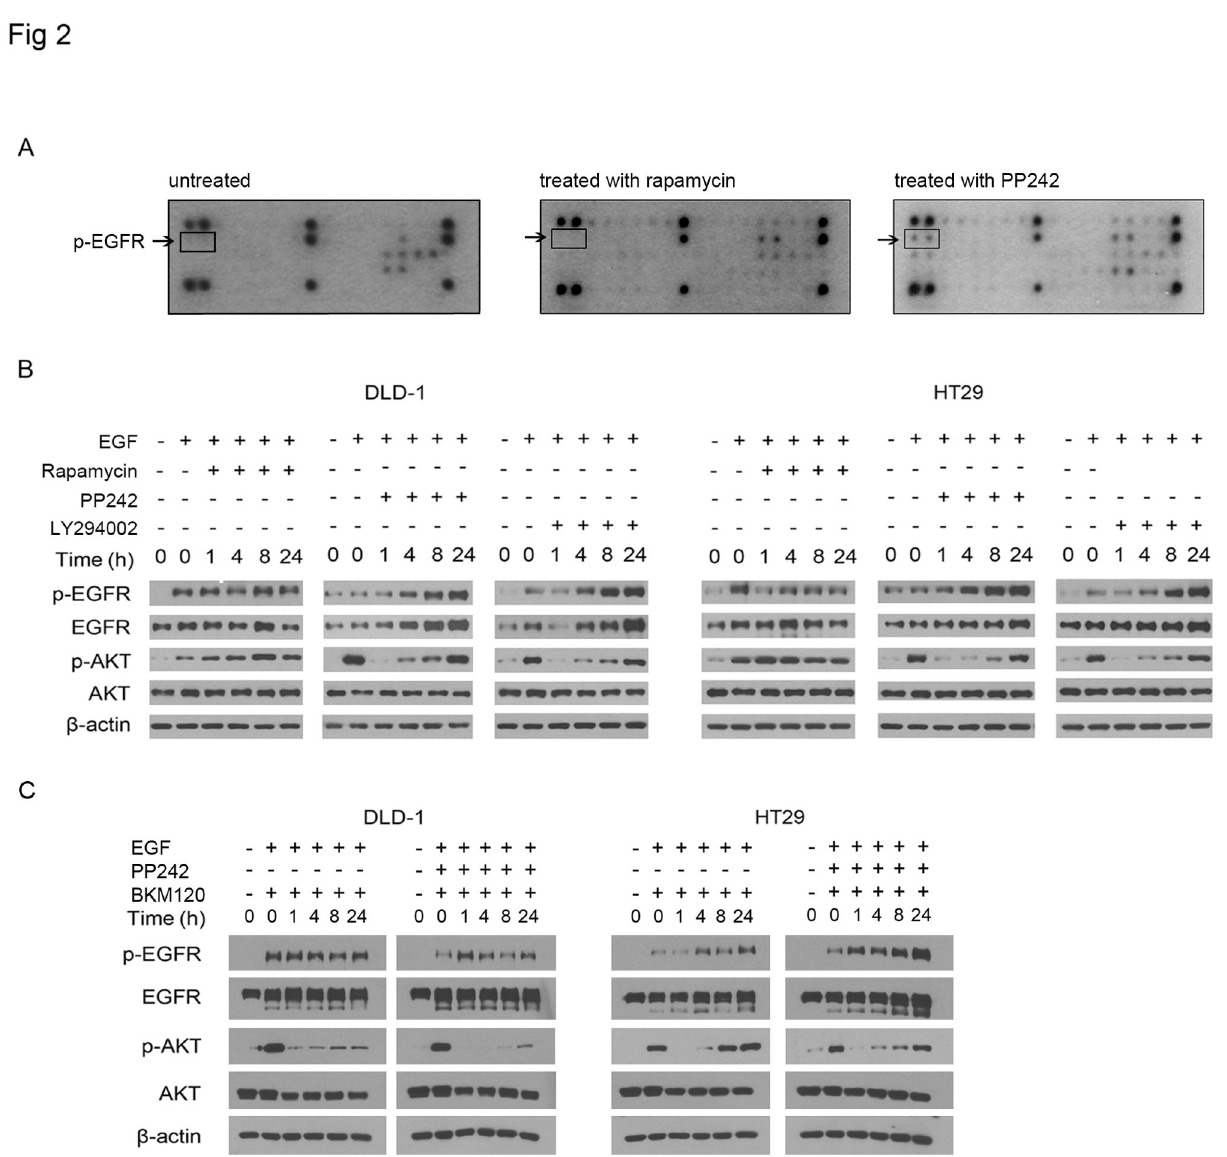
Figure 2. PP242 treatment leads to the EGFR phosphorylation in the carcinoma cells. (A) RTK arrays of DLD-1 cells untreated or treated with rapamycin (0.1 μM) and PP242 (1 μM) for 72 hours show the phosphorylated EGFR (p-EGFR) as indicated by arrows. (B) DLD-1 and HT29 cells grown in EGF (50 ng/ml) containing medium were treated with rapamycin (0.1 μM), PP242 (1 μM), or LY294002 (20 μM) for the indicated hours and examined by western blotting for the presence of the phosphorylated and unphosphorylated proteins ( left ). (C) DLD-1 and HT29 cells grown in EGF (50 ng/ml) containing medium were treated with PP242 (1 μM) or BKM120 (1 μM) for the indicated hours and tested by western blotting for the presence of the proteins ( left